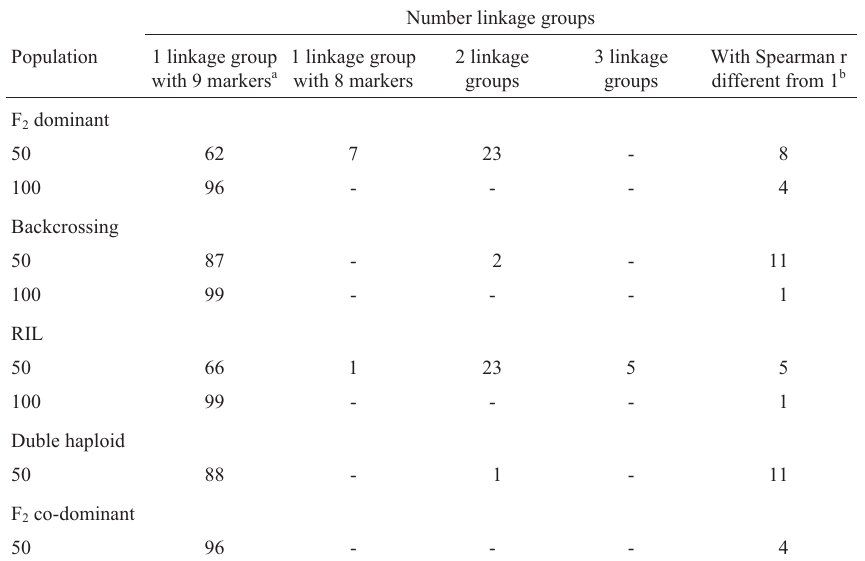
Table 1 - Number linkage groups formed and Spearman correlation differing from 1 for different population types and